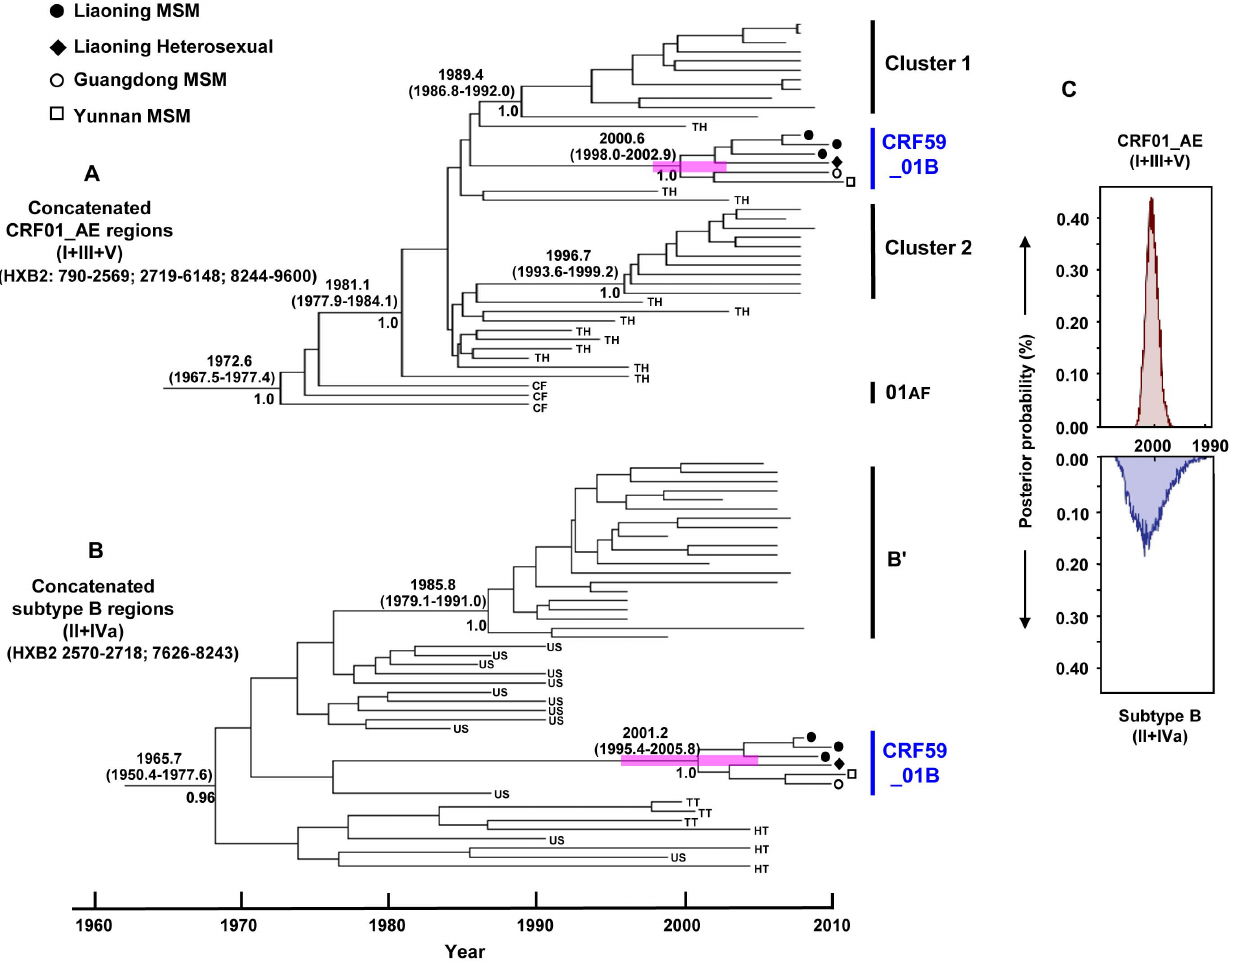
Figure 4. Maximum clade credibility (MCC) trees of CRF59_01B. The MCC tree was obtained by Bayesian Markov Chain Monte Carlo (MCMC) analysis of the concatenated CRF01_AE [(Regions I + III + V) (HXB2: 790–2569; 2719–6418; 8244–9600)] regions and subtype B [(Regions II + IVa) (HXB2: 2570–2718; 7626–8243)] regions, using a relaxed clock model in GTR + G4 with a constant coalescent model. Analyses were implemented in BEAST v.1.6.0. HIV-1 subtype C sequences are used as an out-group. The medians of the estimated tMRCAs with 95% highest probability density (HPD) (in parentheses) and the posterior probability ( . 0.95) of the nodes relevant to this study are indicated. (C) The distribution of the posterior probability of the estimated tMRCAs for CRF59_01B as well as the related CRF01_AE lineages (top) and subtype B lineages